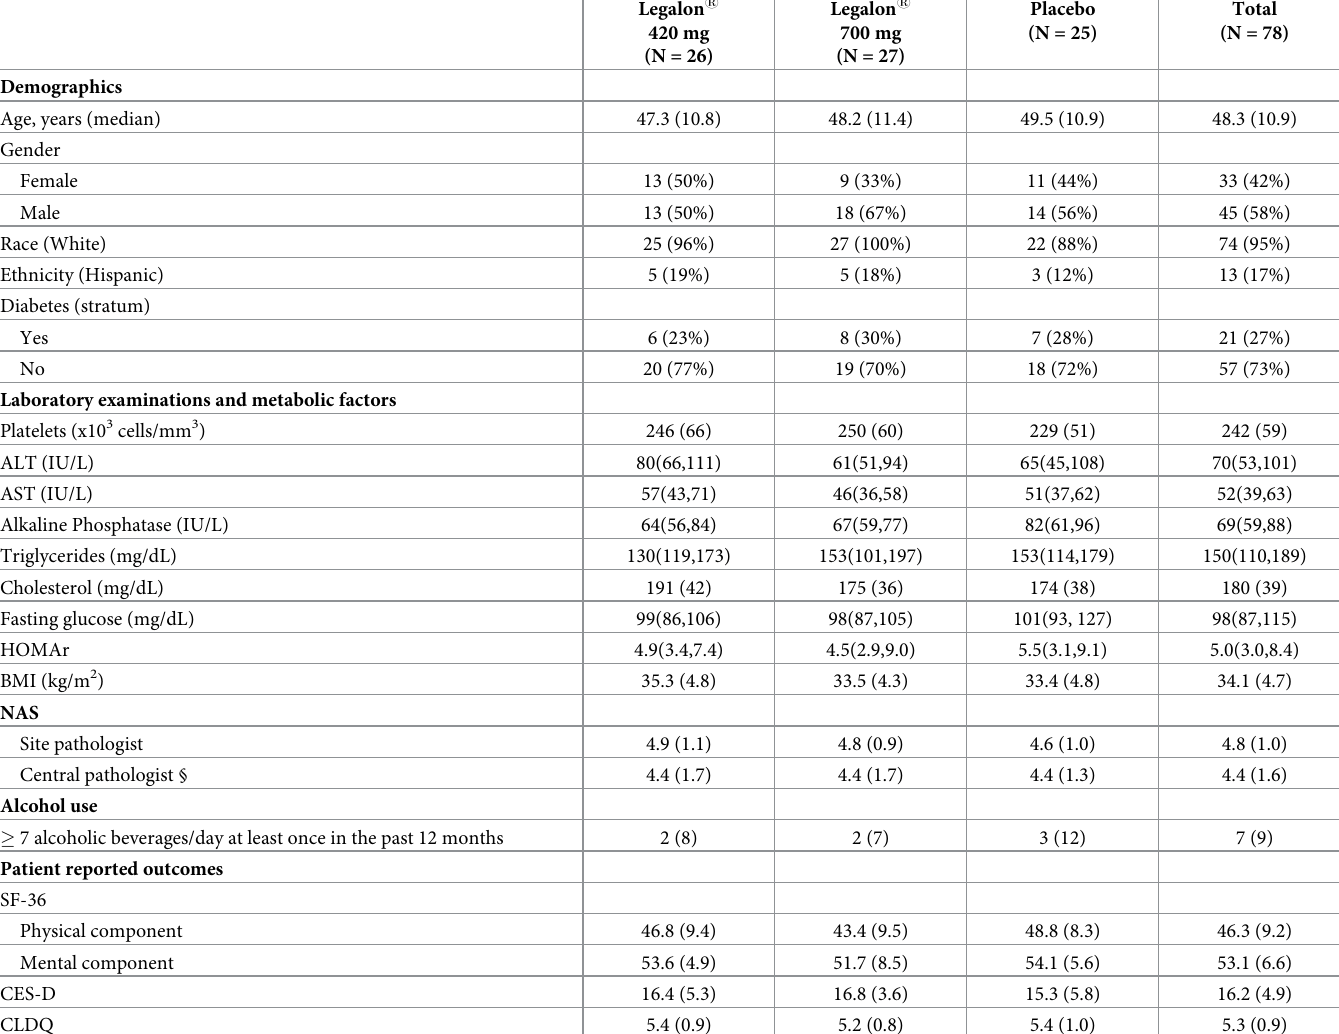
Table 1. Baseline characteristics of the study